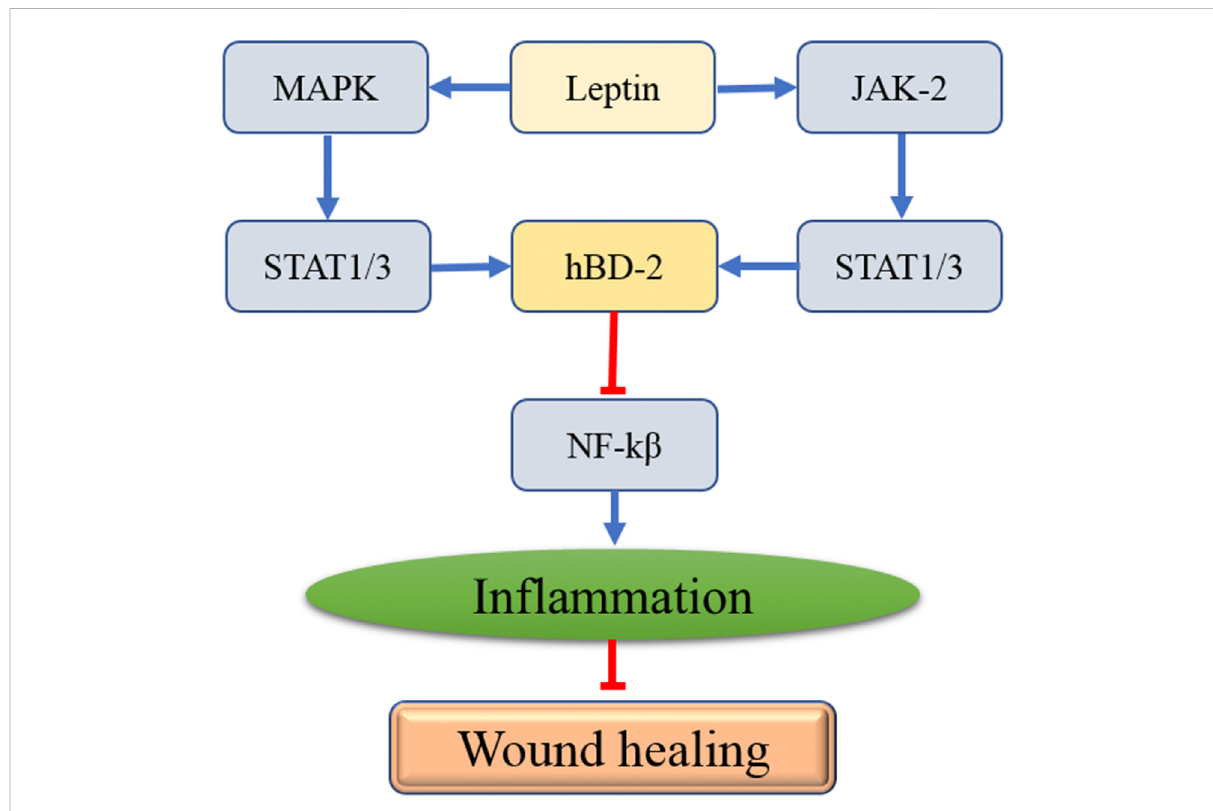
FIGURE 2 The interaction between leptin and the affected genes in the process of wound